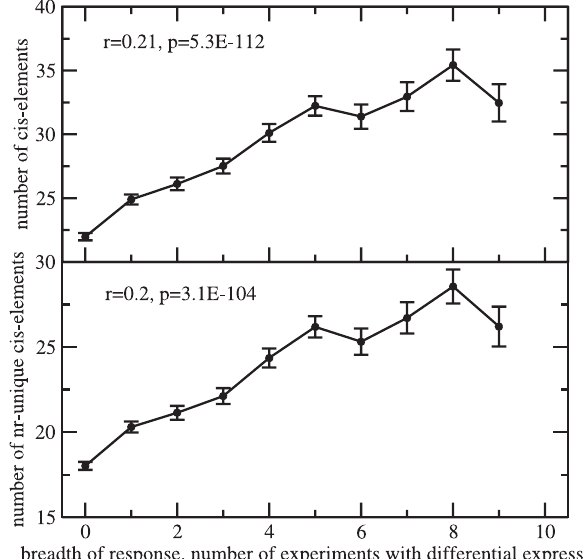
Figure 3. Correlation of the Number of Regulatory cis -Elements in Gene Upstream Promoter Regions Up to 3,000 Nucleotides in Length or Truncated at the Next Upstream Gene Boundaries (Variable Promoter Length) with the Breadth of Differential Gene Expression Response Plotted are the mean values and associated standard errors of the mean. Pearson linear correlation coefficients, r, and associated p -values are given for all raw data pairs (for all genes considered in the analysis). doi:10.1371/journal.pgen.0030011.g003 PLoS Genetics |